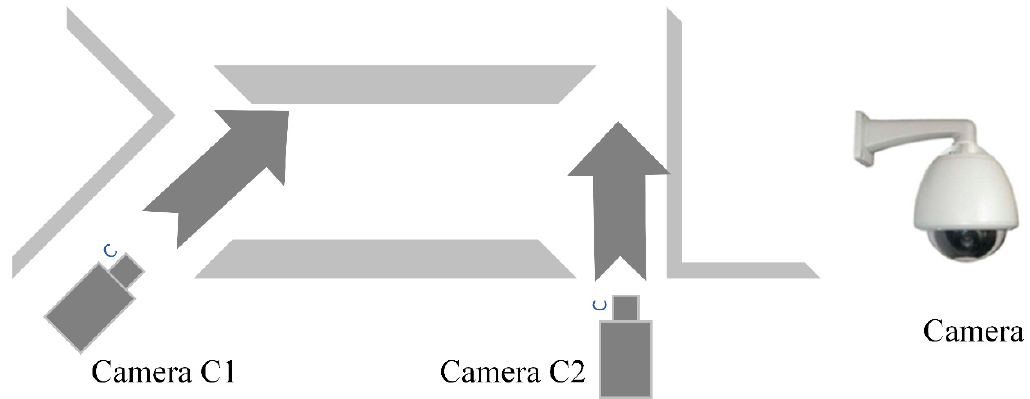
Figure 3. The data acquisition of multi camera visual sensor networks. These scenes are captured under disjoint cameras.